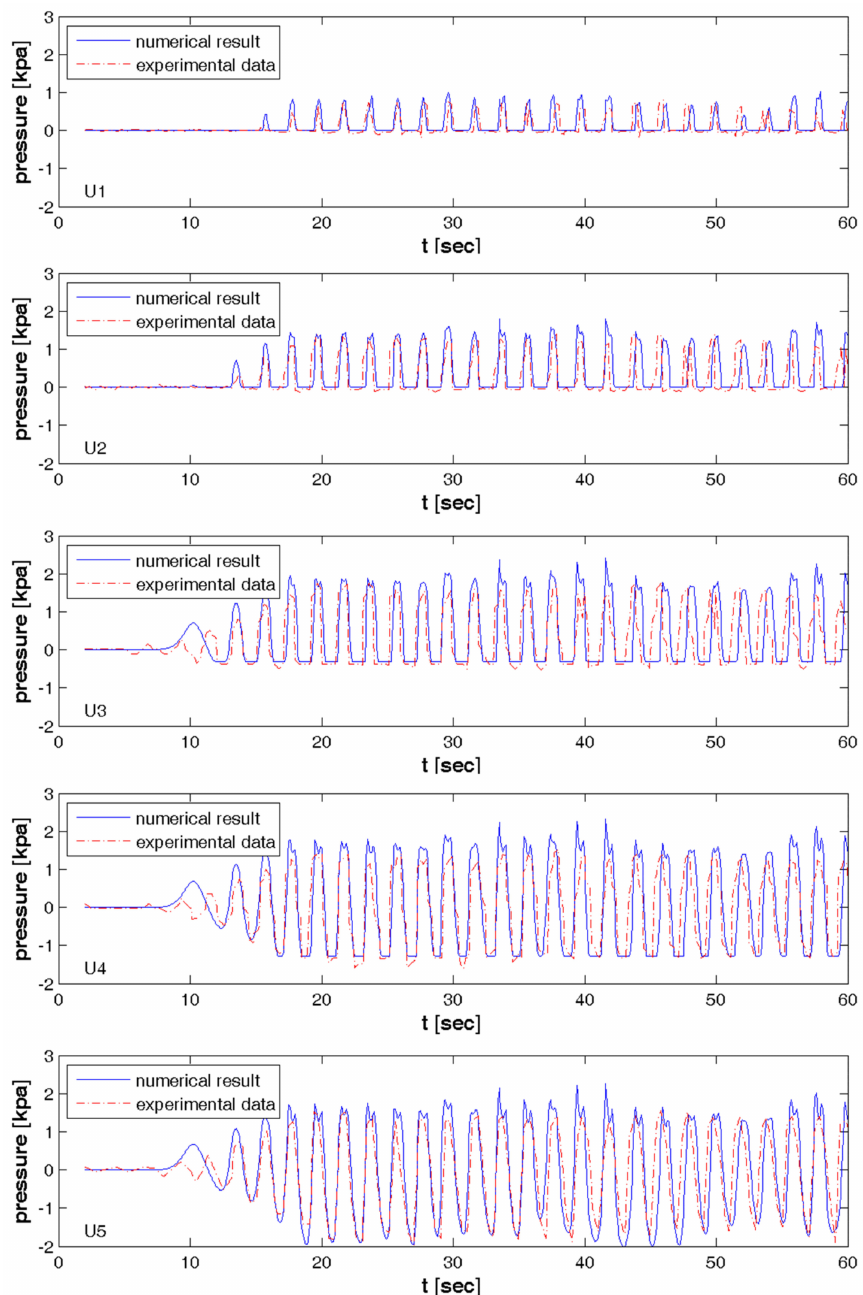
Figure 3. Comparisons of the dynamic wave pressure along the front face of the caisson breakwater in the typhoon wave condition (H = 0.25 m, T = 2 s) between numerical results (dashed line) and experimental data (solid